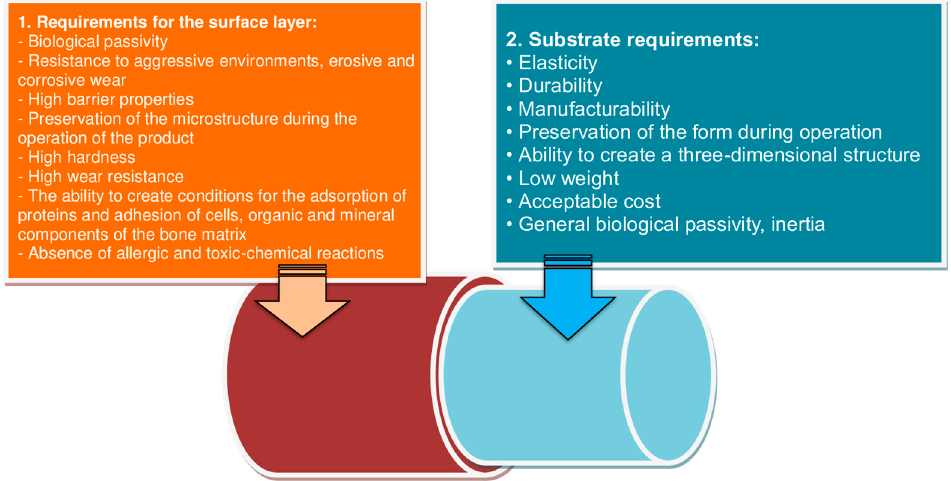
Figure 5. Concept of the compositional structure of critical medical devices operating inside the human body.